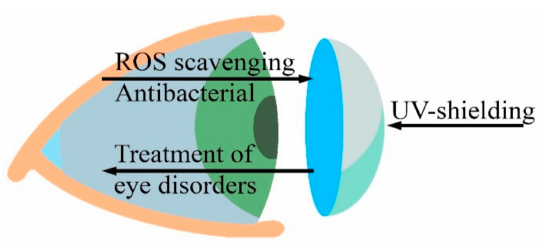
Figure 7. CeNPs can provide additional advantages for contact lens polymeric